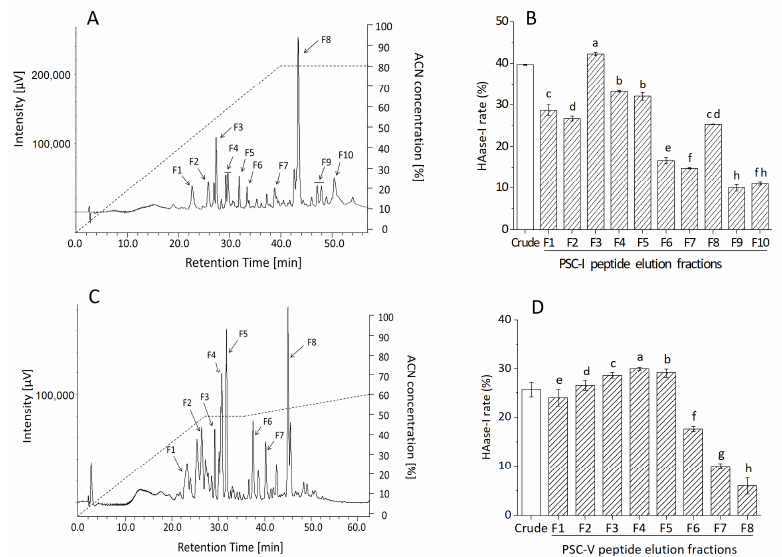
Figure 3. Purification profile and HAase-I rate of fractions of PSC-I peptide <30 kDa ( A , B ) and PSC- V peptide <30 kDa ( C , D ) by RP-HPLC. Different superscripts note the significant differences as compared with the crude sample ( p < 0.05).